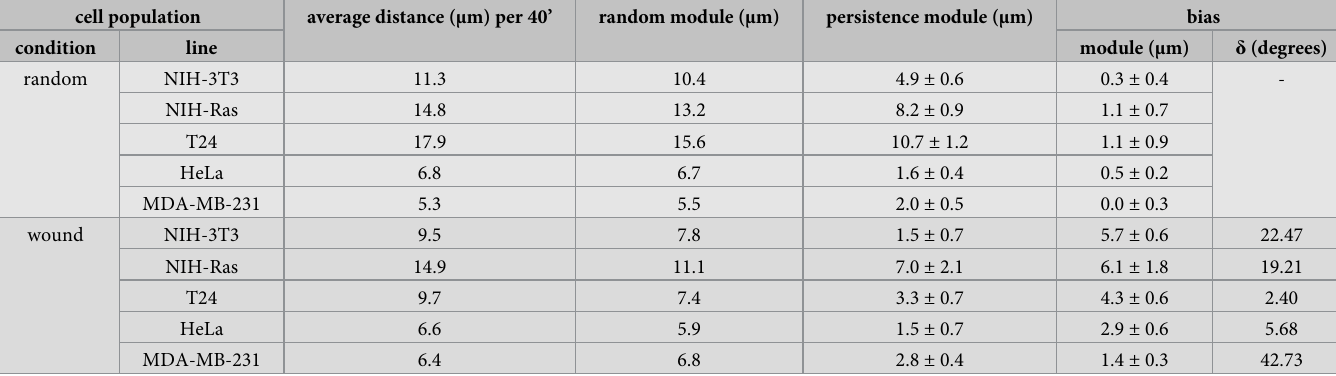
Table 3. Characterization of movement of different cell lines in different experimental conditions. cell